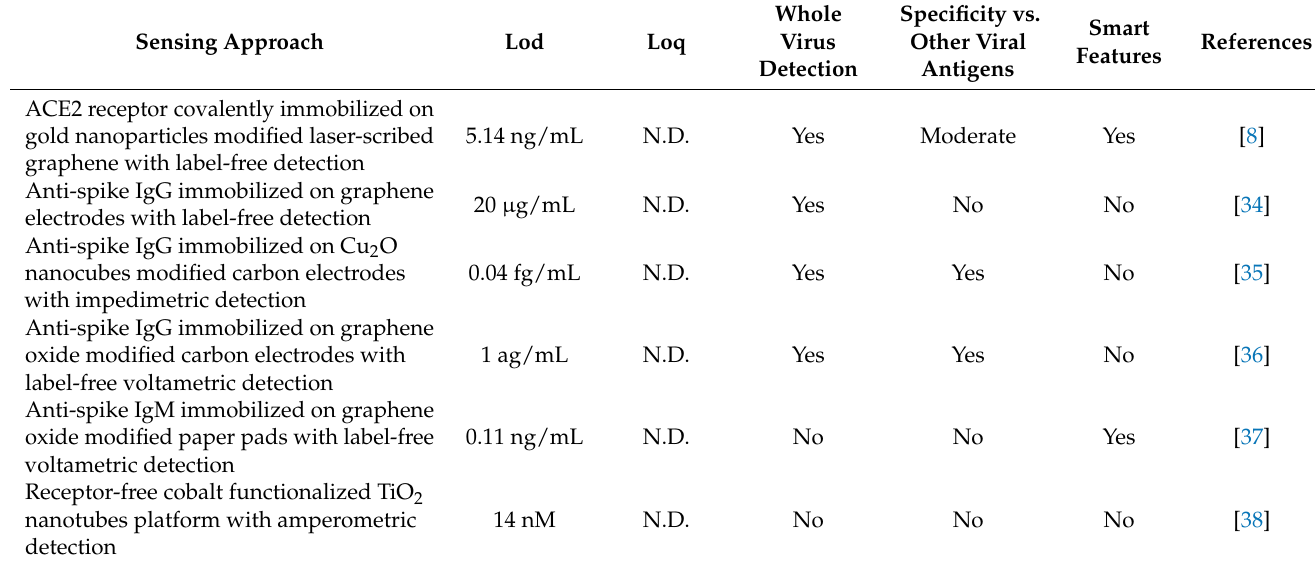
Table 1. Comparison of the performance of the developed immunosensor with other electrochemical immunosensors for SARS-CoV-2 spike